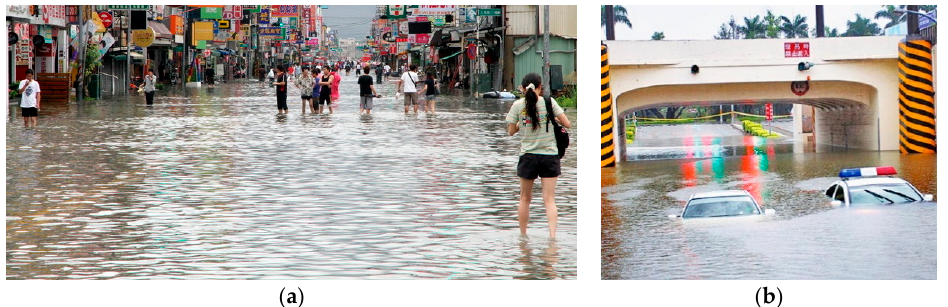
Figure 2. Photos of flooding in Tainan City. ( a ) flooding on the street; ( b ) flooding in the